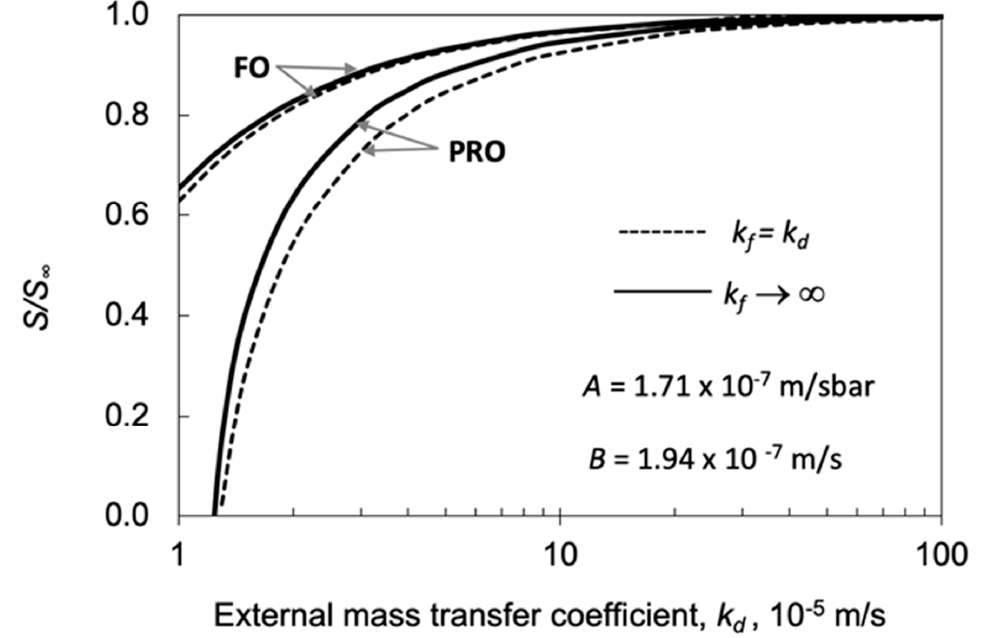
Figure 12. Value of S/S ∞ as a function of the draw side mass transfer coefficient with both operating modes, i.e., PRO and FO; C d = 1.0 M; k f → ∞ ; for PRO: J w , ∞ = 4.92 × 10 − 6 m/s; S ∞ = 803 µ m; for FO: J ∞ = 3.0 × 10 − 6 m/s; S ∞ = 395 µ m; other parameters as they are given in caption of Figure